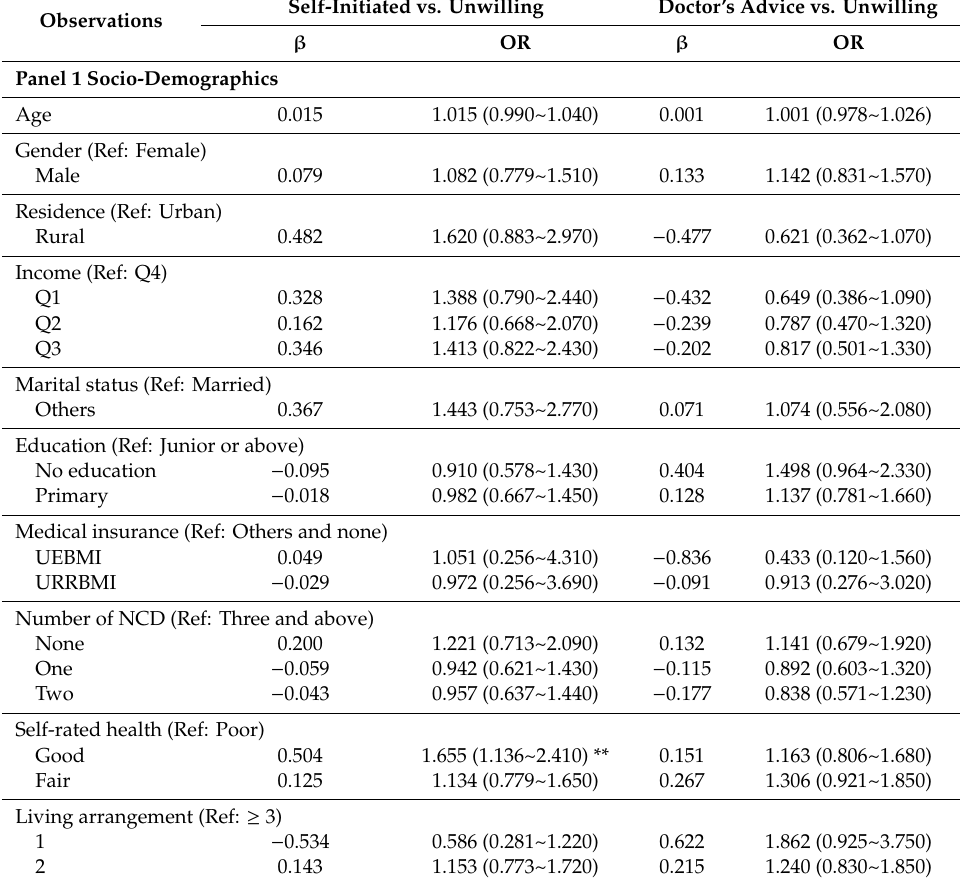
Table 2. The multinomial logistic regression analysis of older people’s willingness for DR. Self-Initiated vs. Unwilling Doctor’s Advice vs. Observations